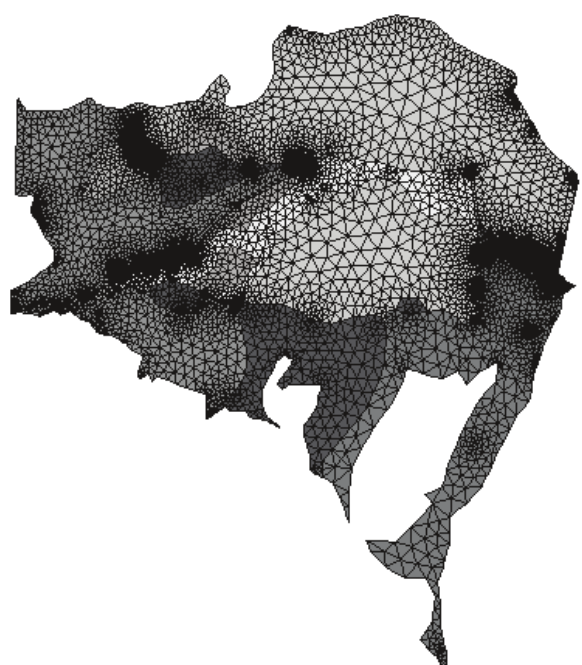
Fig. 8. Finite element mesh for the terrain model